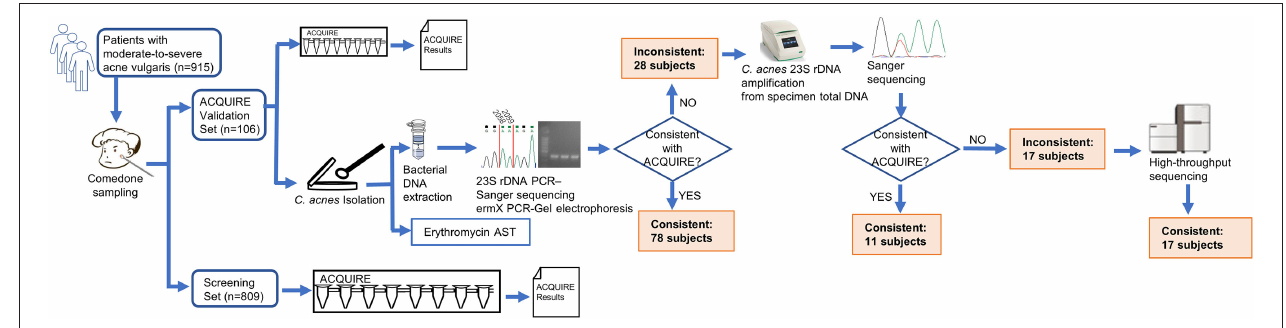
FIGURE 1 | Schematic diagram of study design. The patients enrolled were sampled and randomly assigned into two sets. For patients in the Cutibacterium acnes quantitative PCR (qPCR)-based antibiotics resistance assay (ACQUIRE) Validation Set whose ACQUIRE results and result of culture method were inconsistent, the C. acnes 23S recombinant DNA (rDNA) was amplified from specimen total DNA and subject to Sanger sequencing. If the ACQUIRE results and the result of Sanger sequencing were still inconsistent, the amplification product was subject to high-throughput sequencing (Illumina Miseq), sequence filtration (sequences with < 95% similarity to C. acnes were discarded), and mutation rate